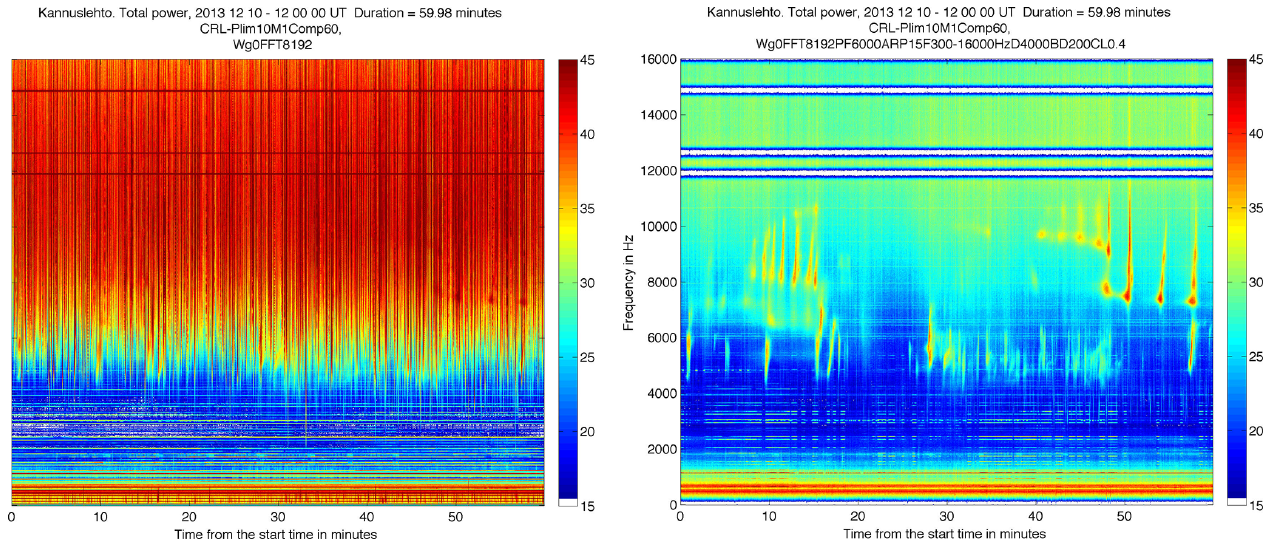
Figure 11. (a) A dynamic spectrum (frequency versus time with color-coded intensity) of VLF observations between 0 and 16kHz. Above 5kHz, worldwide lightning activity covers the whole spectrum. This is very typical for ground-based VLF observations. (b) The same spectrum with a lightning stroke suppression filter applied, thereby new types of VLF emissions become visible (figures by Jyrki